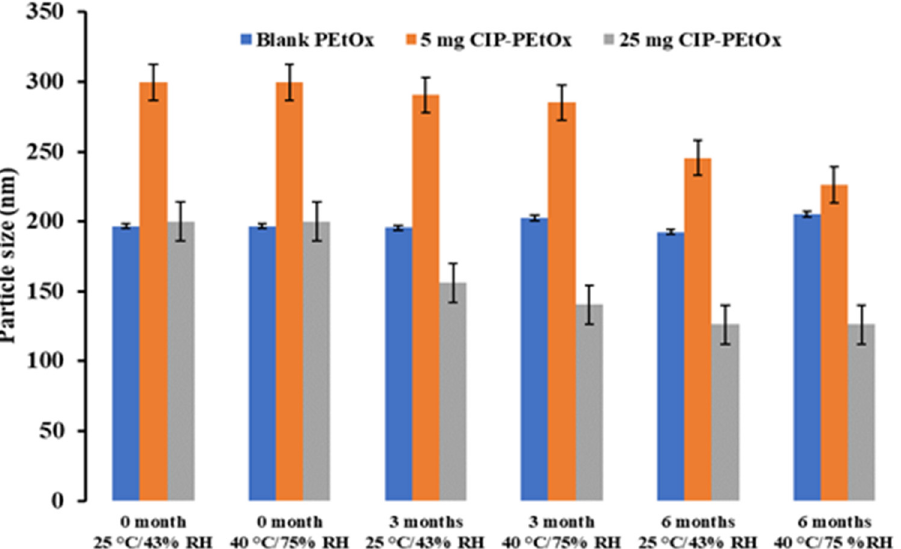
Figure 1. The average particle size of blank and CIP-loaded PEtOx NPs before and after storage at 25 ◦ C/43% RH and 40 ◦ C/75% RH. (data mean with ± SD, n = 3). The average particle size of blank PEtOx NPs stored at 25 ◦ C/43% RH remained close to the initial particle size of 196 nm ( p -value = 0.2) after 3 and 6 months. However, the particles stored at 40 ◦ C/75% RH showed a significantly increased particle size ( p <